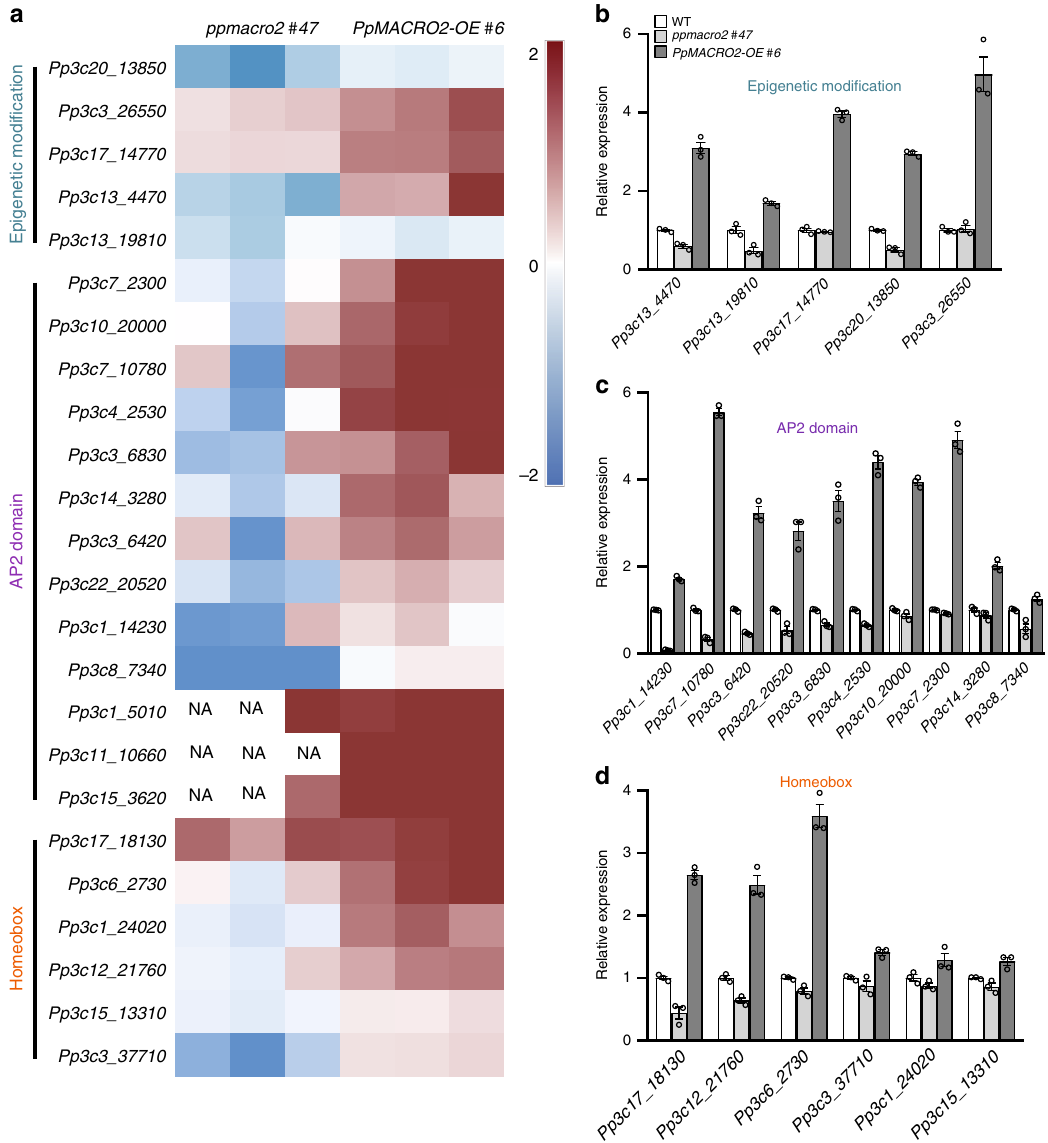
Fig. 6 Differentially expressed genes related to epigenetic modi fi cation and stem cell development in ko and OE lines of P. patens . a Transcriptional pro fi le from RNA-seq data for a subset of genes related to epigenetic modi fi cation and developmental transcription factors in WT plants, as well as ko and OE mutants. Total RNA extracted from WT plants and mutants was used for RNA-seq analyses. b – d Transcript abundance of the subjected genes was con fi rmed through qRT-PCR with three independent biological replicates, normalized to PpEF1a . Phytozome identi fi er is used for each gene, and additional information for each gene is provided in Supplementary Table 3. Data show means±